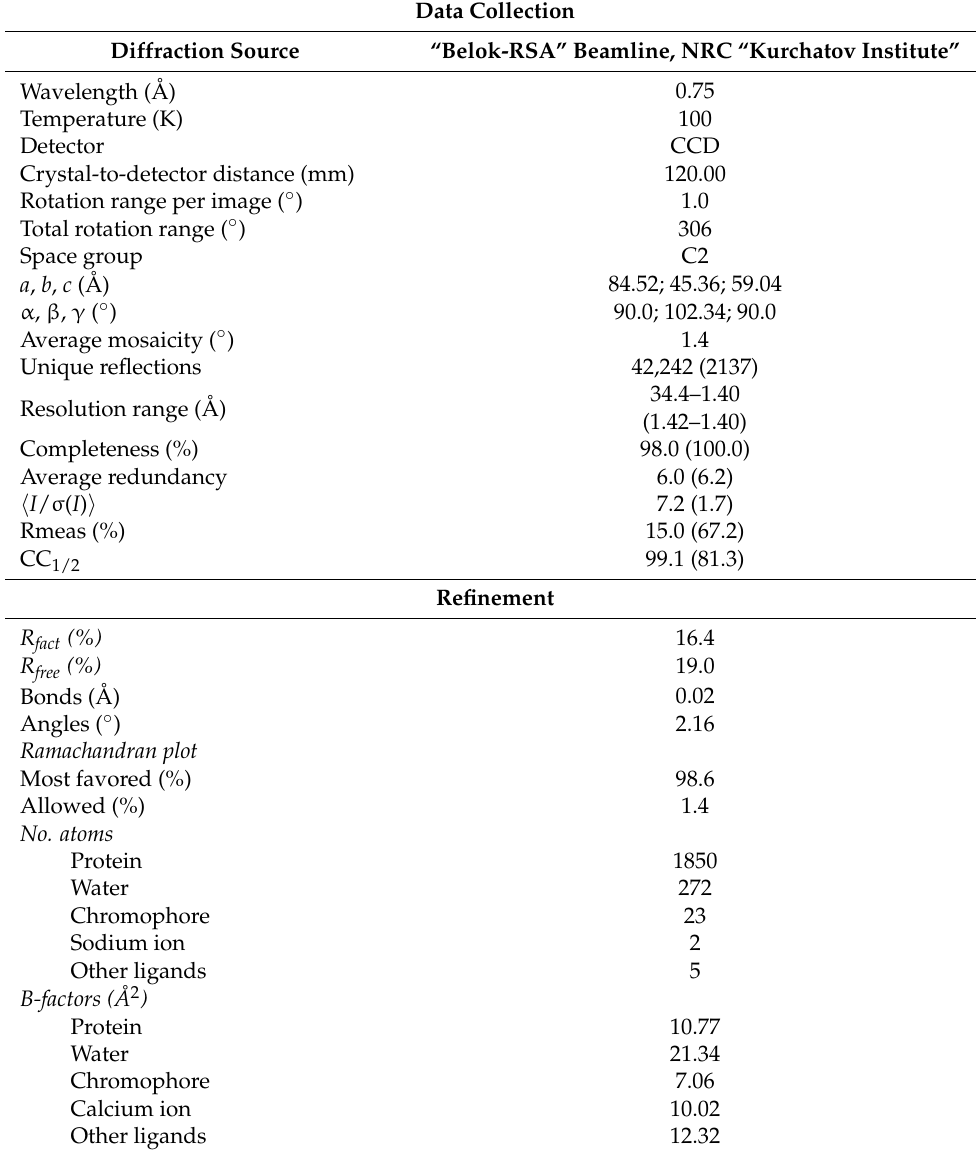
Table 3. Data collection, processing and refinement. Values in parenthesis are for the highest- resolution